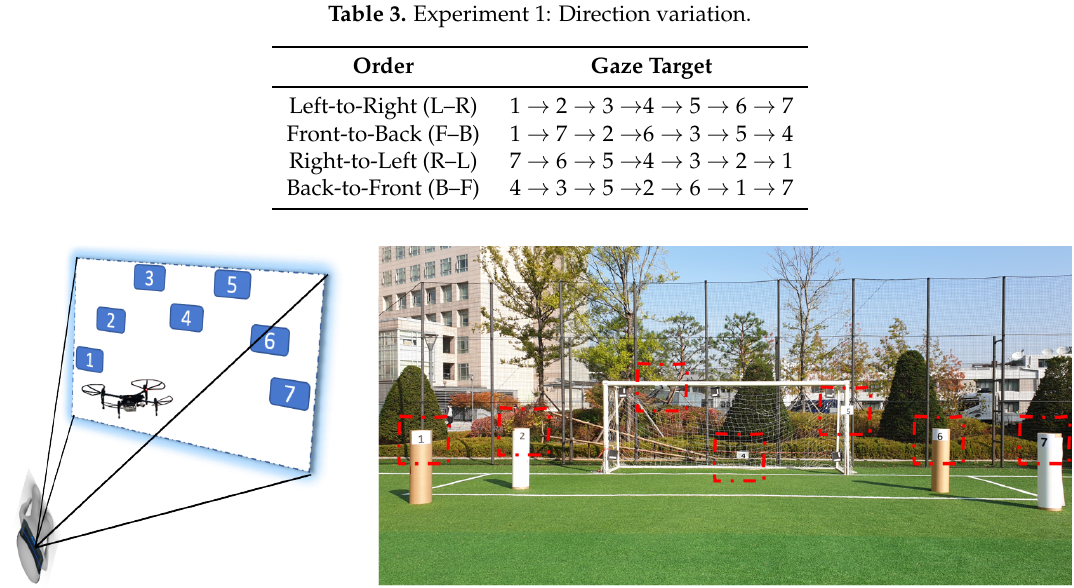
Figure 4. Experiment 1: ( a ) Conceptual design; ( b ) Physical target setup in an outdoor environment.